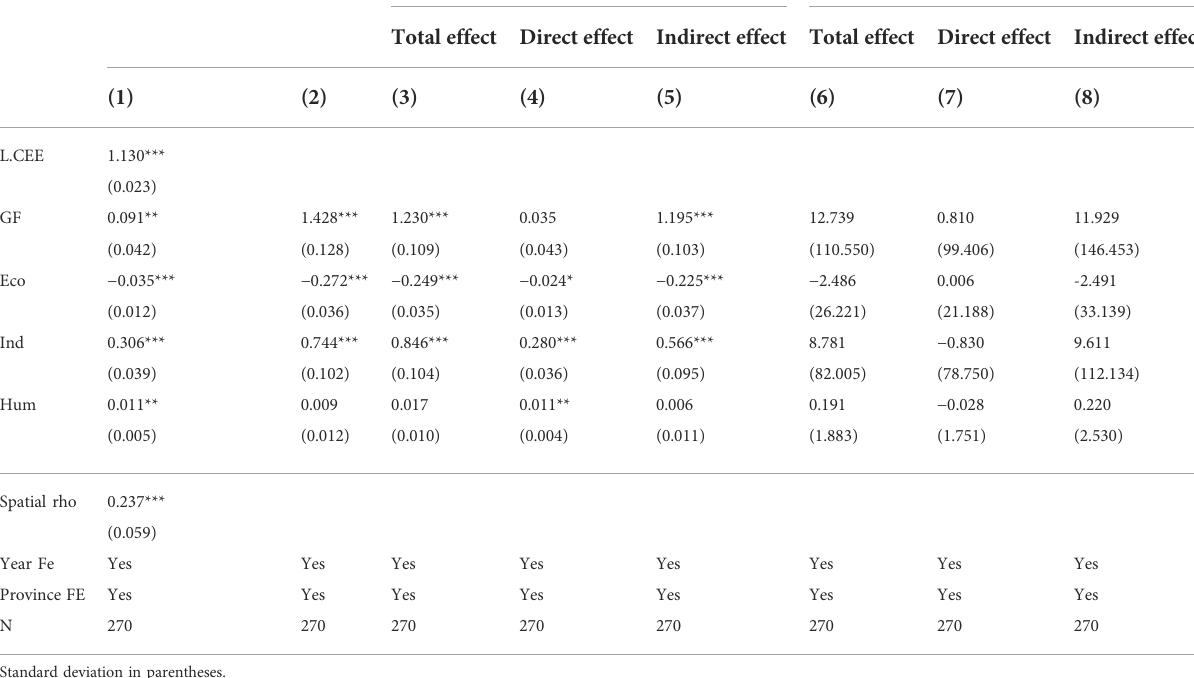
TABLE 4 Spatial estimation result.